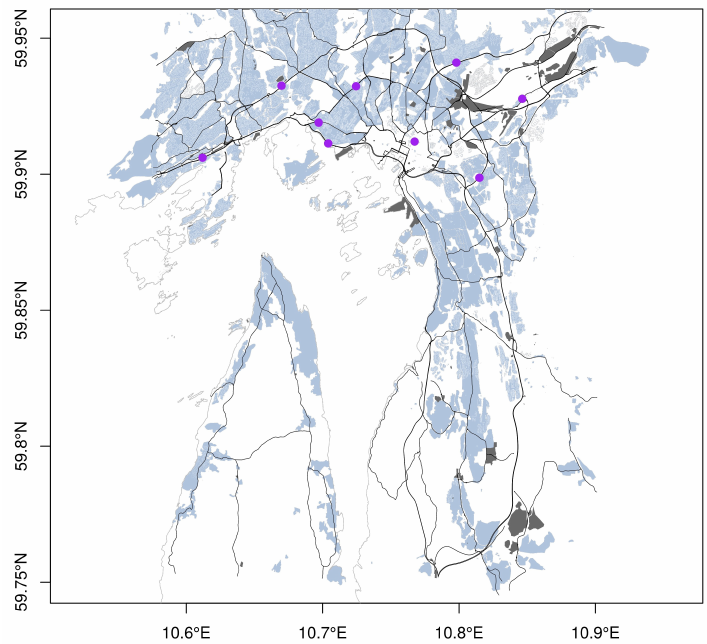
Figure 2. Map of Oslo with its residential (blue) and industrial (dark gray) areas, its roads (primary, secondary, motorway and trunk) and its air quality (AQ) station network measuring NO 2 (purple circle). GIS data come from Open-Street